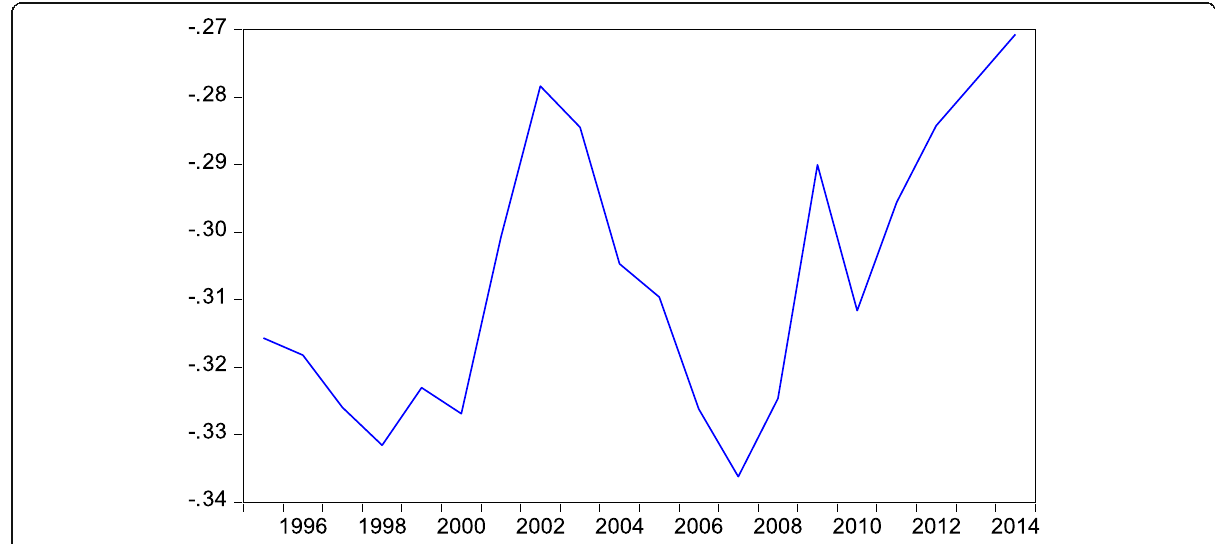
Fig. 6 Translog estimate of the elasticity of GDP to the price of capital, Switzerland